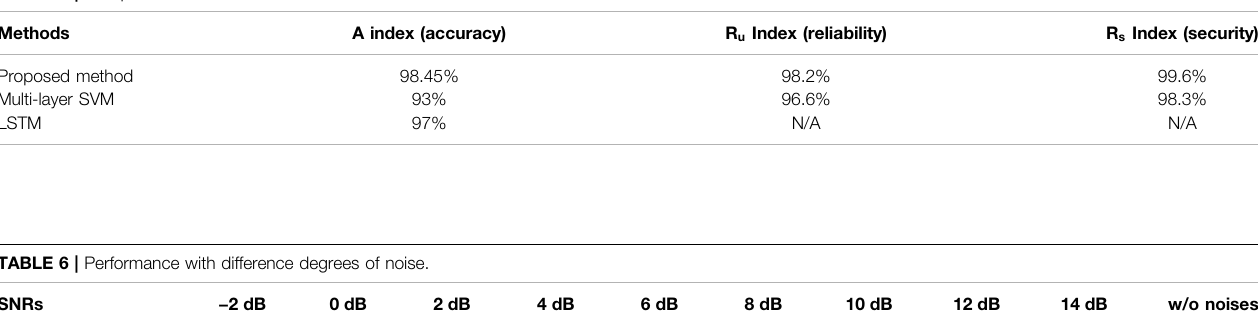
TABLE 5 | Comparison of the TSA results.